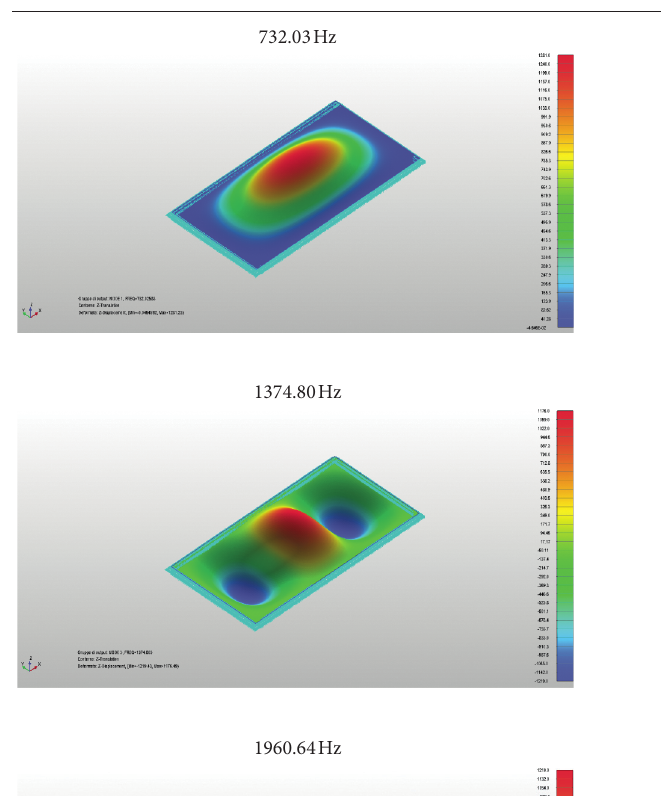
Table 8: FEM simulation: mode shapes and natural frequencies (Case